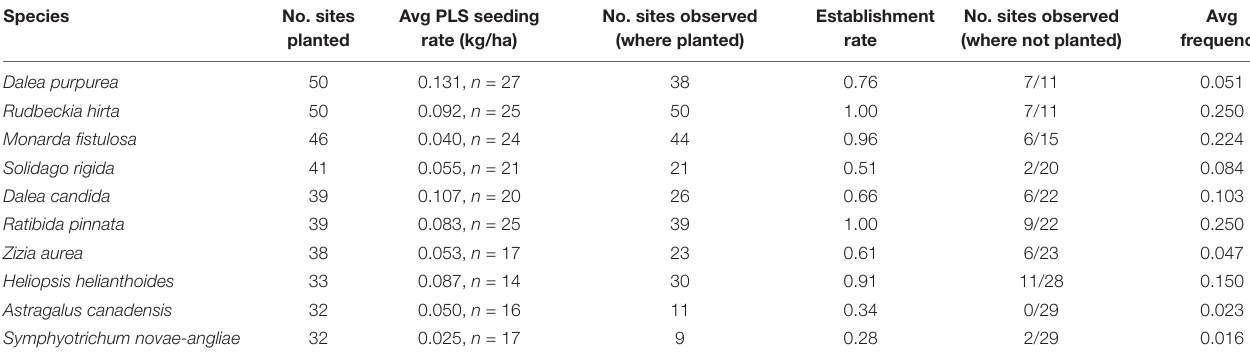
TABLE 5 | Establishment and colonization patterns of the 10 most commonly planted forbs across study sites (for all forbs, see Supplementary Table S4 ). Species No. sites Avg PLS seeding No. sites observed planted rate (kg/ha) (where